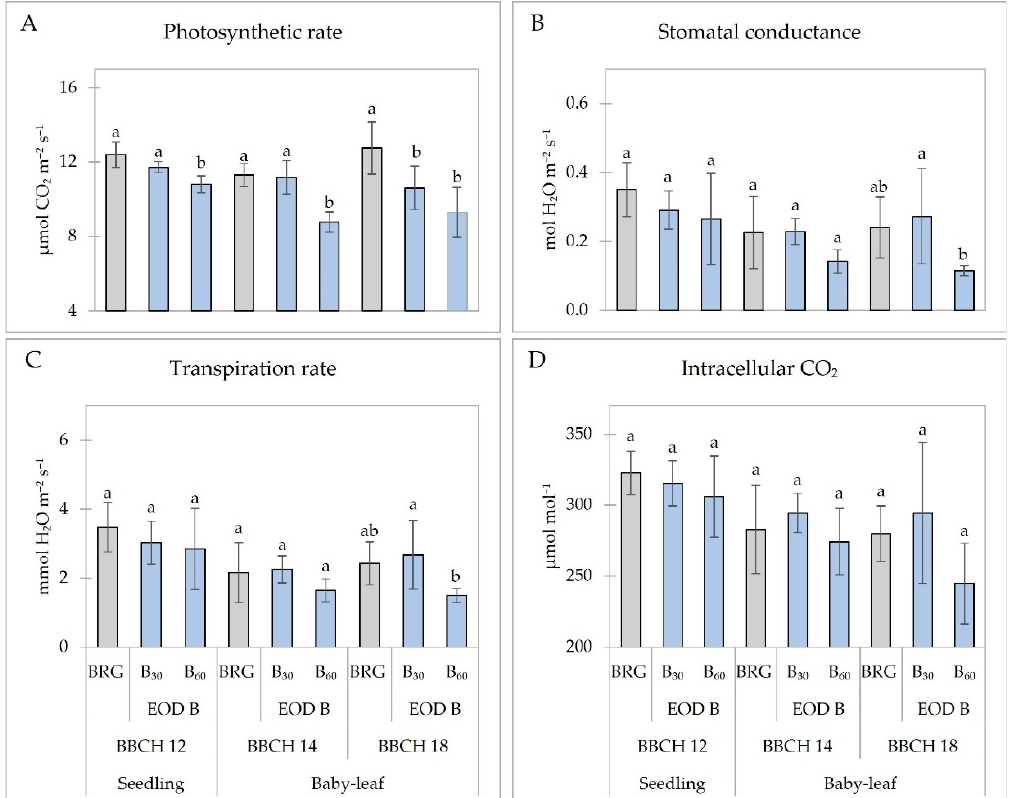
Figure 2. Photosynthetic indices (( A ) photosynthetic rate; ( B ) stomatal conductance; ( C ) transpira- tion rate; ( D ) intracellular CO 2 ) of lettuce plants at different development stages. BRG , 5% blue (peak = 450 nm), 85% red (peak = 660 nm), 10% green (peak = 530 nm) for 16 h d –1 (control; from 06:00 to 22:00); B 30 and B 60 , PPFD of end-of-day lighting with blue (peak = 450 nm) at 30 and 60 µmol m –2 s – 1 , respectively; EOD, end-of-day lighting for 4 h d –1 (from 22:00 to 02:00). Data are means of two replications with three samples per replication (n = 6). Means with different letters are significantly different from the control treatment (BRG) at p < 0.05.